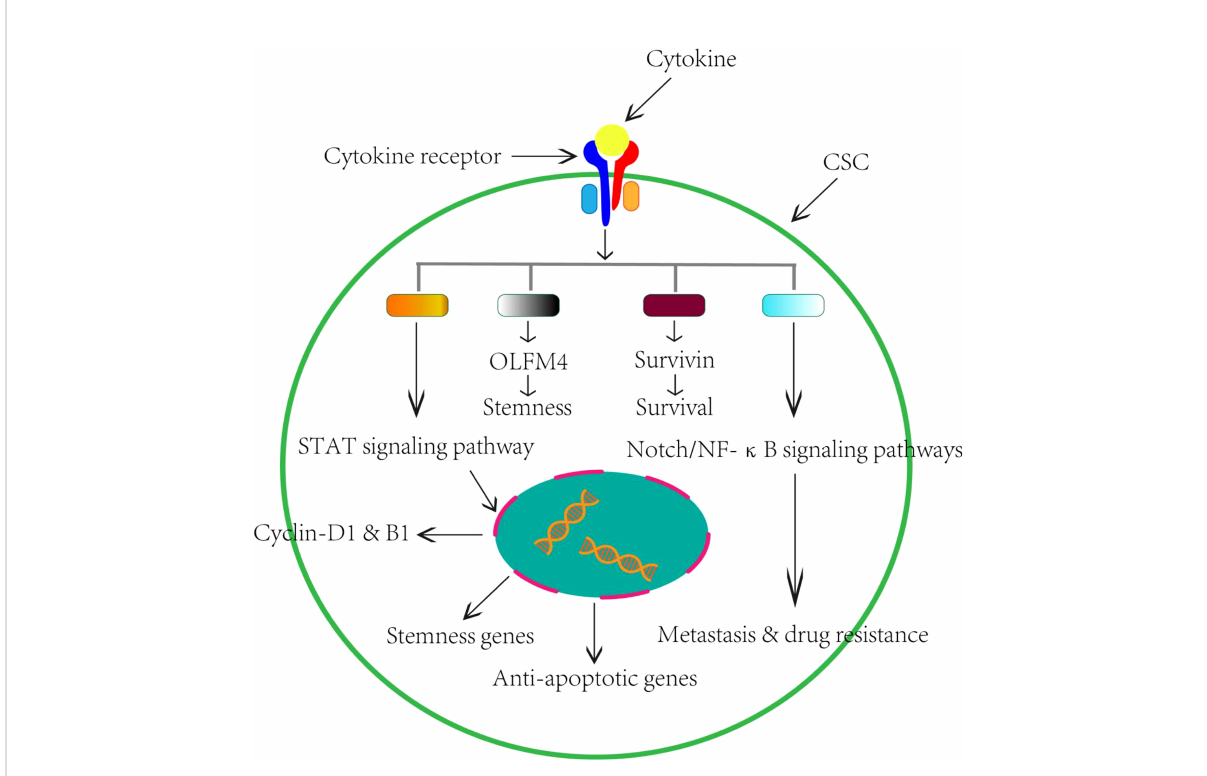
FIGURE 1 Schematic perspectives of potential role of cytokines on CSCs in the CRC. Based on current research fi ndings, we therefore summarized the regulatory effects of cytokines on CSCs in the